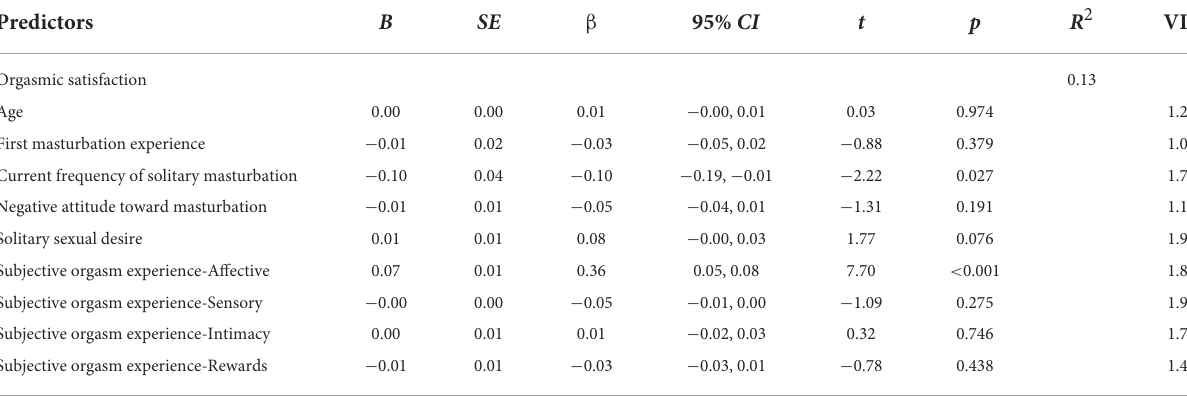
TABLE 3 Multiple regression models for orgasmic satisfaction in men.